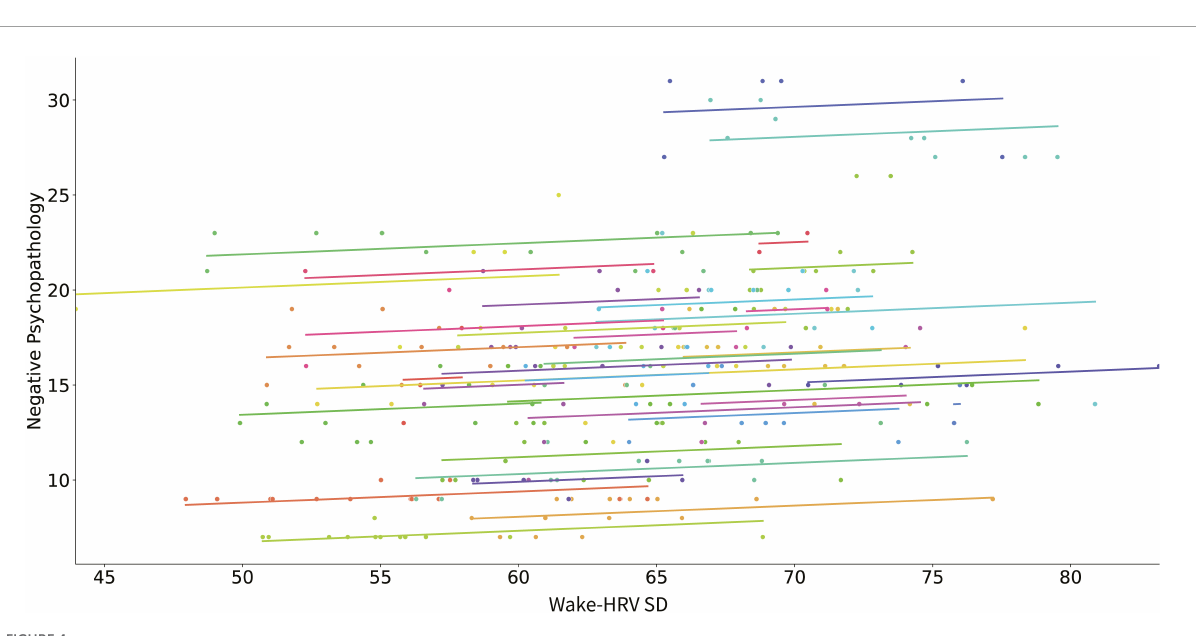
The relation of heart rate and positive